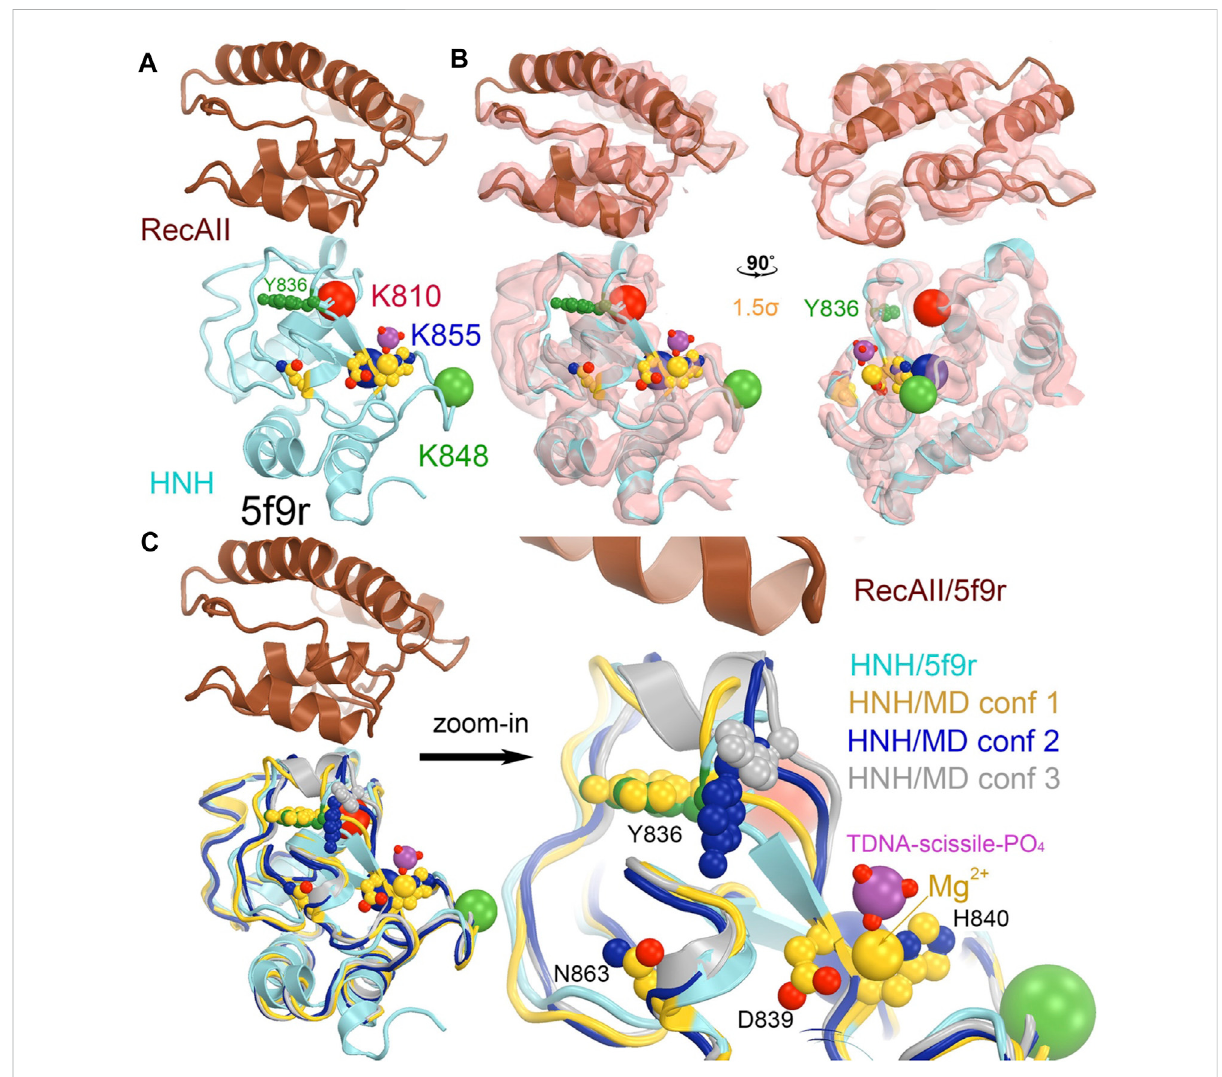
FIGURE 7 Locations of threeMD-derived HNHconformations attheHNH-Rec II interface. (A) HNH(cyan)-Rec(brown) interface from the5b9r complex. (B) Crystallographic electron density map (contoured at 1.5 σ ) for the 5f9r complex in two orthogonal views. (C) Alignment of the MD-derived three HNHconformations(gold,blue,andsilver)withthe5f9rHNH(cyan)structure.ThetDNAscissilephosphateisshowninmagenta, Mg 2+ ioningold,as well as three catalytic residues (D839/H840 and N863) in an inactive